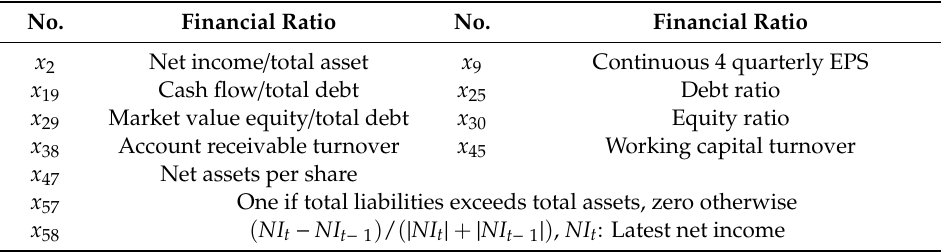
Table 4. Financial ratios selected using the comprehensive training data set of the year ( t − 3 ) . No. Financial Ratio No. Financial Ratio x 2 x